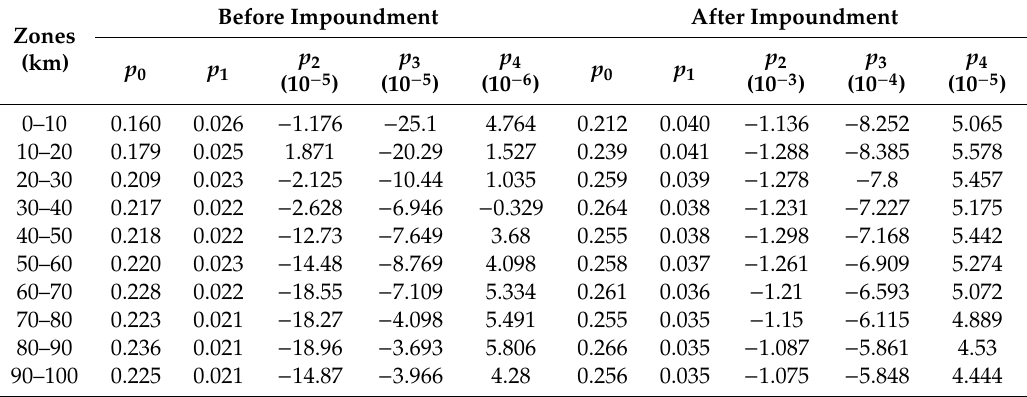
Table 2. Regression coe ffi cients results of relationship between NDVI and climatic factors.